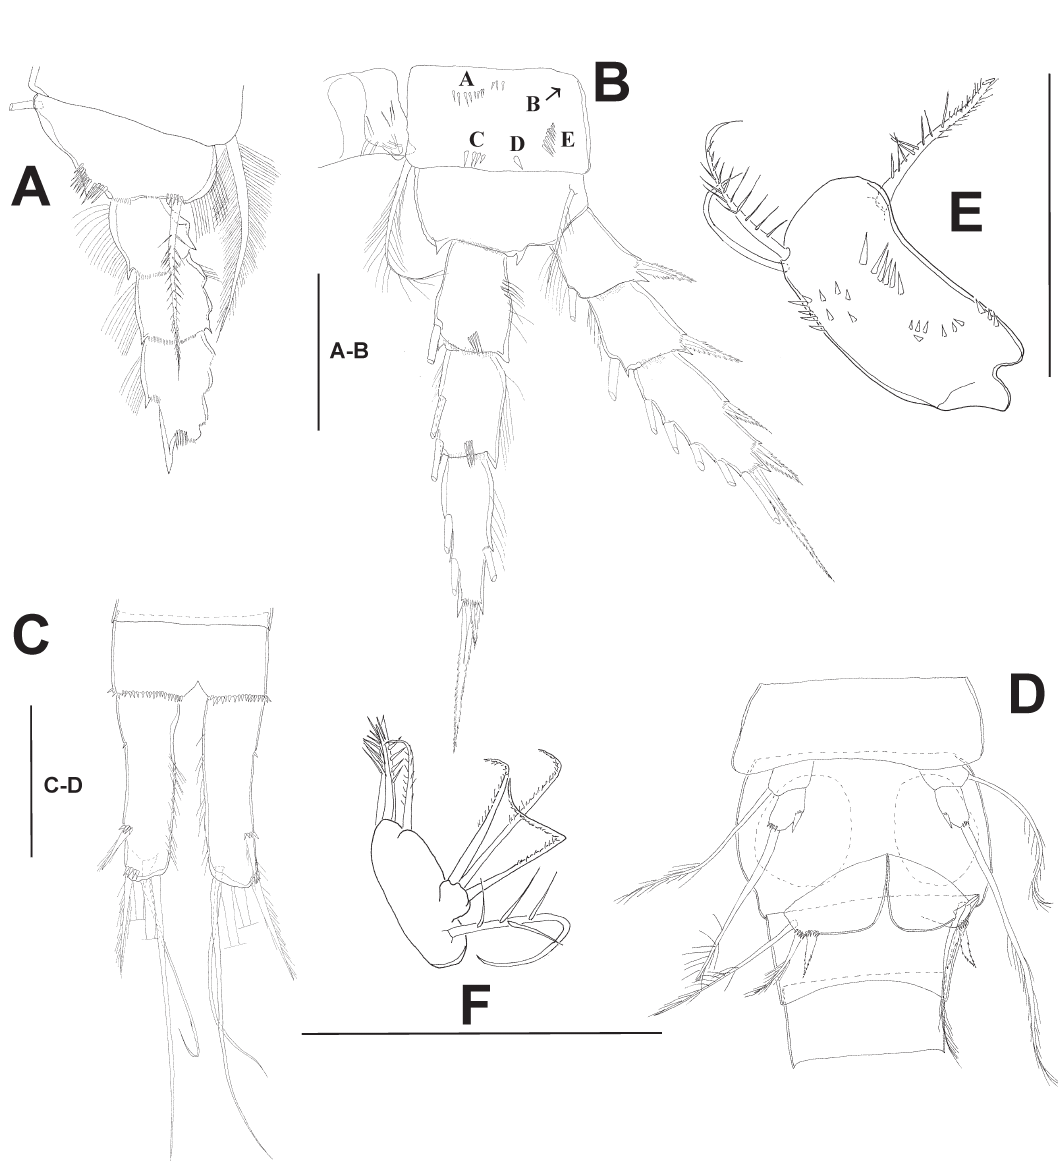
Fig. 8. Cyclops lacustris G.o. sars, 1863. A−B . ♀. A . Leg 1, frontal (Zmo: lectotype designated herein). B . Leg 4, caudal – distal margin of the first and second exopodal segments bearing spinules on the frontal surface only (Zmo: sars coll. 12977 ♀-2). C−F . ♂. C . anal somite and caudal rami, ventral (Zmo: sars coll. 12977 ♂-1). D . Urosomites 1−4, ventral (Zmo: sars coll. 12977 ♂-1). E . antennal coxobasis, caudal (Zmo: sars coll. 12976 ♂-1). F . maxillulary palp (Zmo: sars coll. 12976 ♂-1). scale bars = 100